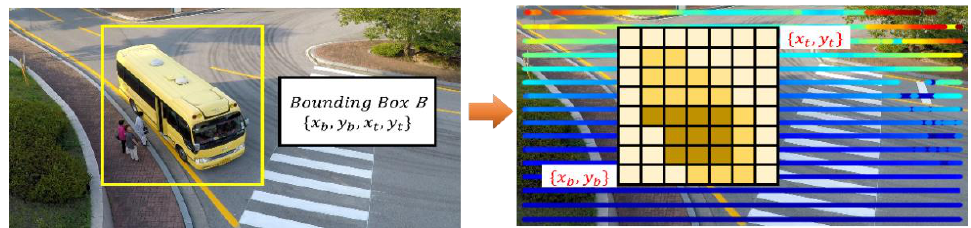
Figure 4. Schematic of estimation of visual distance to target.